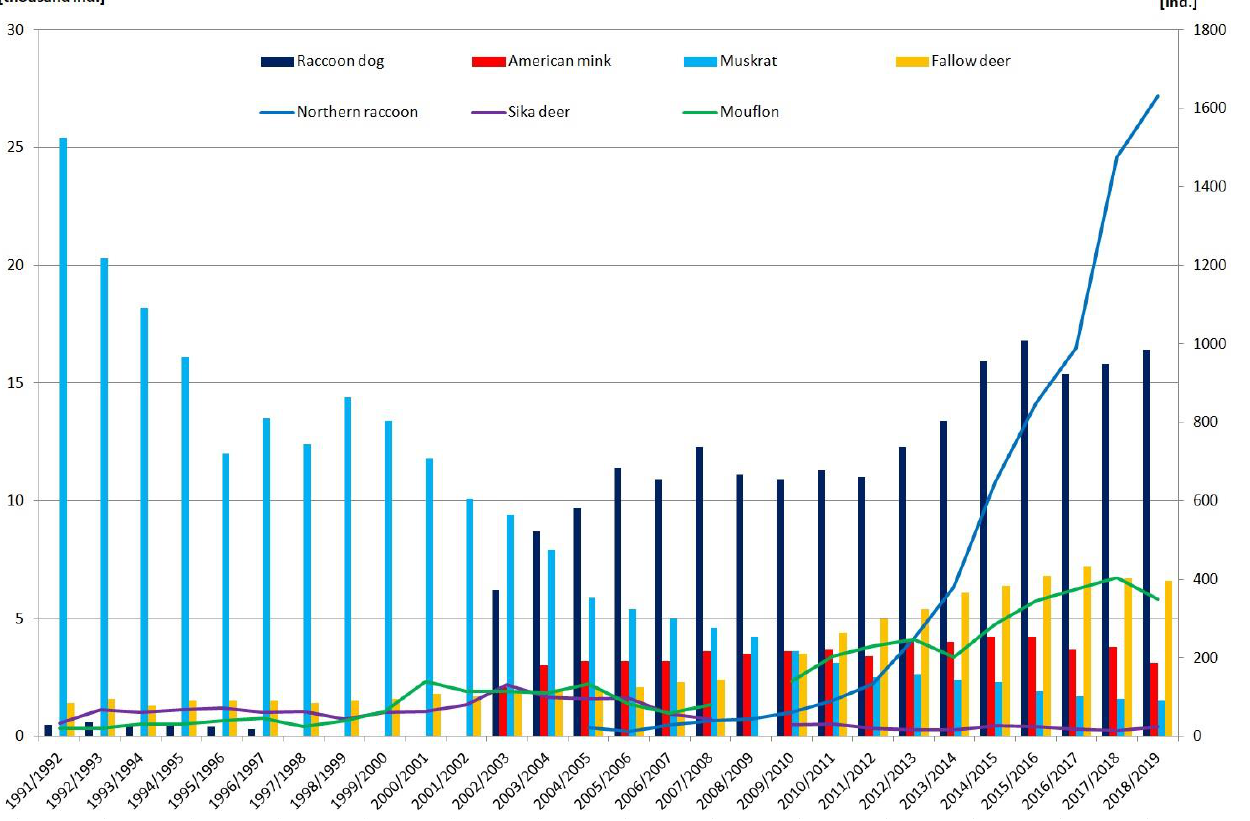
Figure 1. Hunting harvests of seven species in 1991 – 2019. The bars show the harvest in thousands of individuals (thousand ind.), while the solid lines show the exact number of individuals harvested (ind.). The gaps in data continuity for mouflon and sika deer are because they were not hunted in those years, while the lack of data for the raccoon dog is because it was not listed as a game species [18,19].